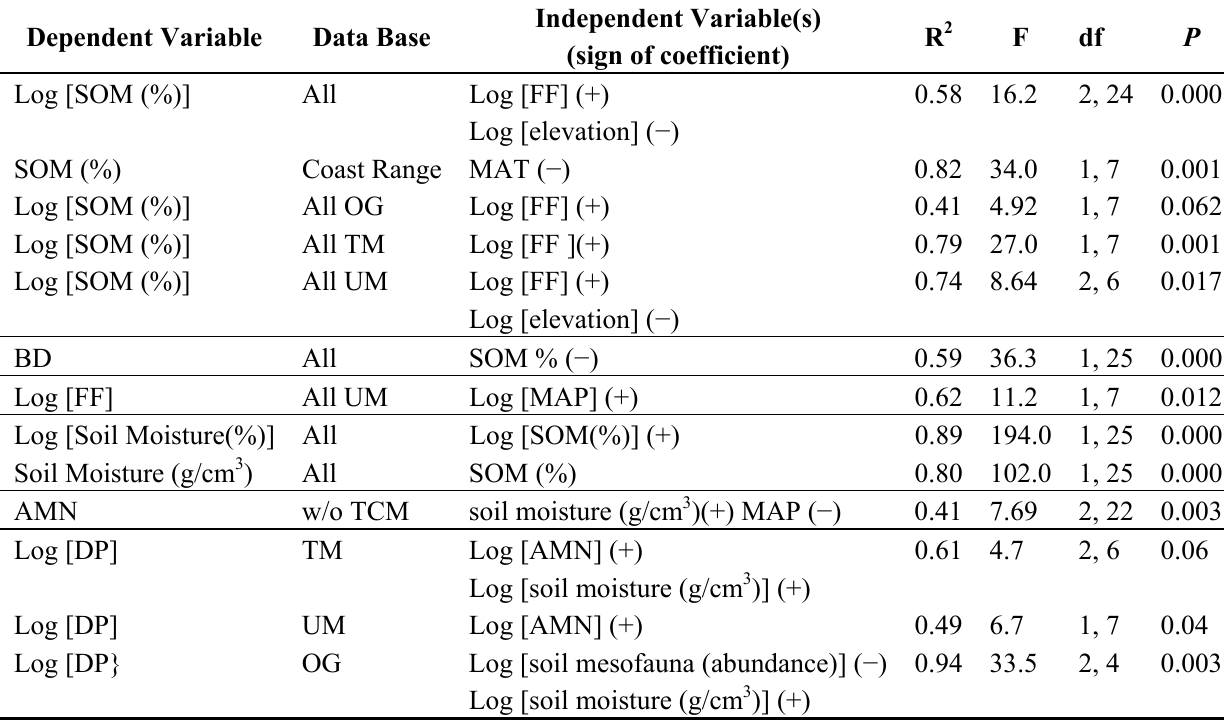
Table 3. Summary of significant regression models for soil organic matter (SOM), bulk density (BD), forest floor depth (FF), soil moisture, anaerobic mineralizable nitrogen (AMN), and denitrification potential (DP). OG = old growth; TM = thinned mature; UM = unthinned mature; MAP= mean annual precipitation; MAT = mean annual temperature; TCM = Taylor Creek mature